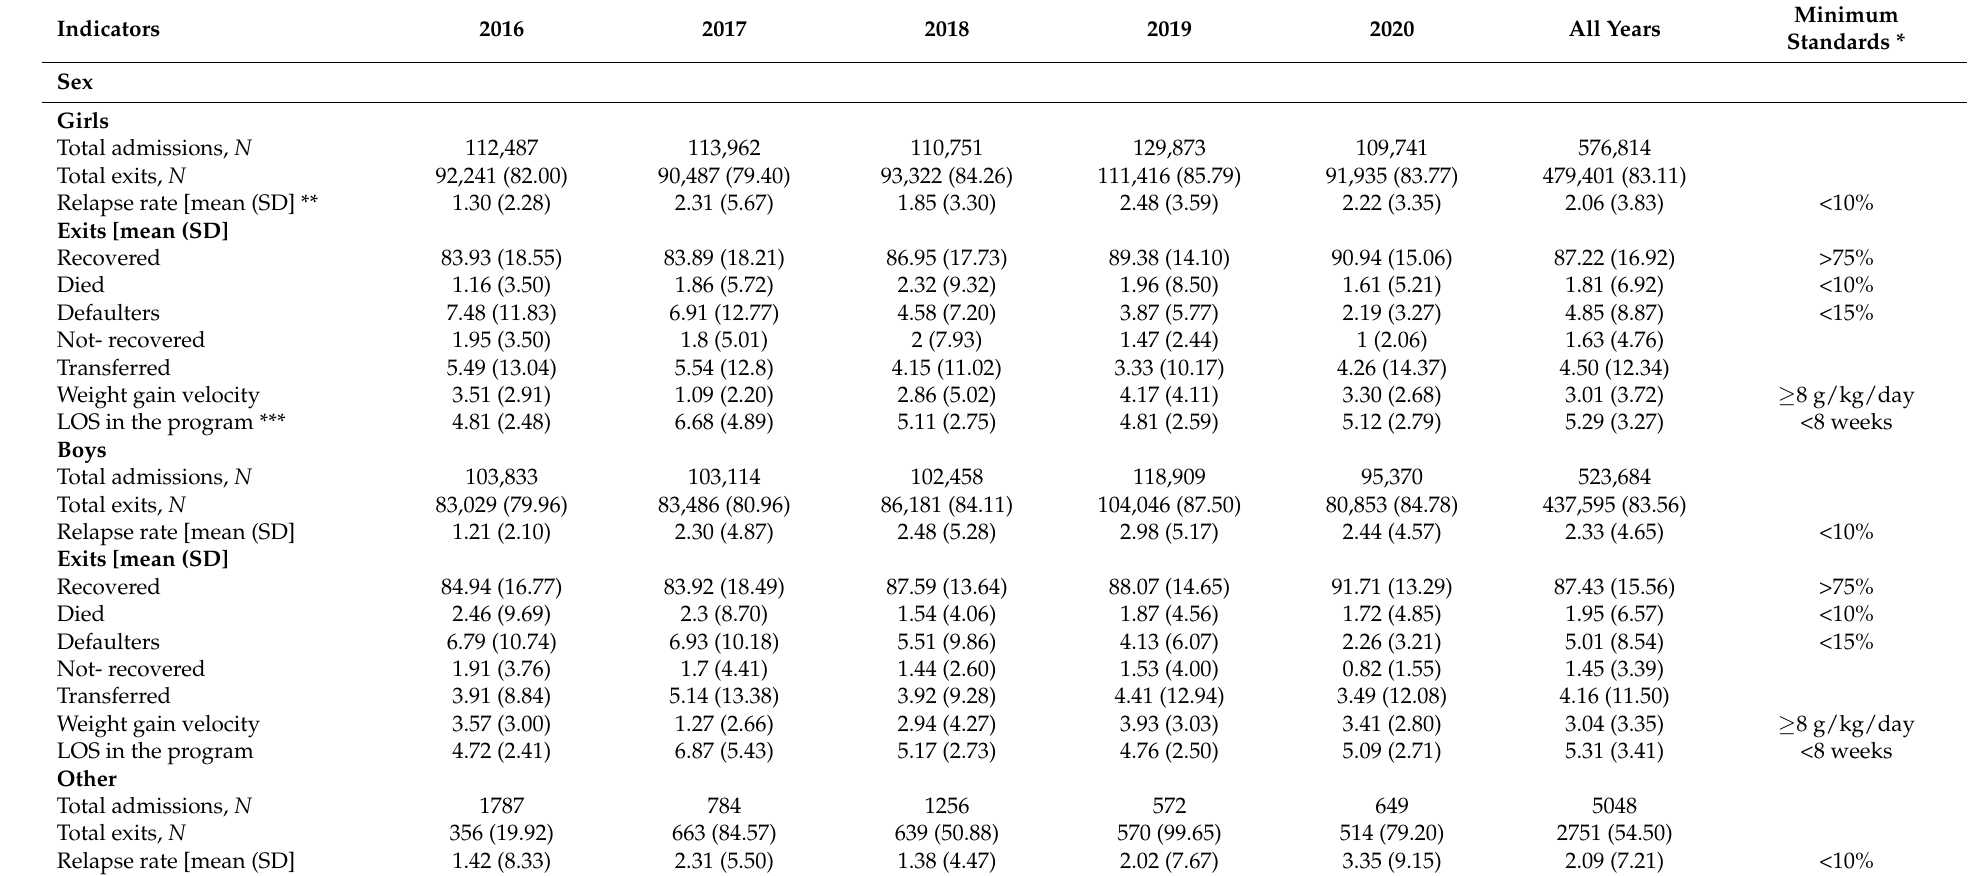
Table 3. Performance indicators of